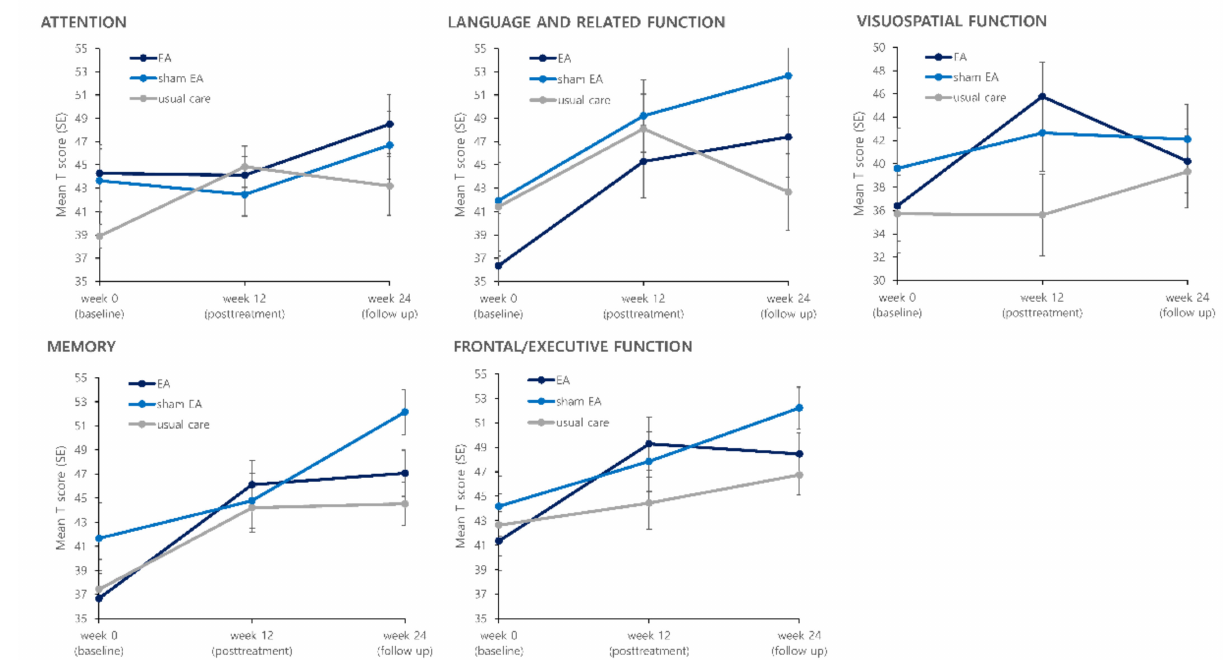
Figure 3. Effects of treatment on five cognitive domains of Seoul Neuropsychological Screening Battery II